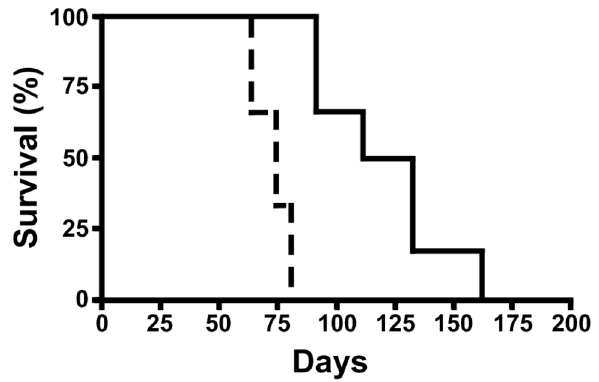
Figure 5. length of survival in the 2F7 NOD-SCID mouse model of AIDS-BL. In one group of mice (n = 6), 2F7 cells were pre- incubated with neutralizing antibody to CXCR5 prior to injection into mice. In the control group (n = 6), cells were pre-incubated with an isotype control antibody. The figure depicts a survival curve for the experiment. The number of days elapsing since the injection of 2F7 cells is shown on the x-axis, and the percentage of surviving mice is shown on the y-axis. The solid line depicts results for the anti-CXCR5 test group; the dotted line depicts results for the isotype control group. These results are significant (p < 0.0007, log-rank test). Two additional replicates of this experiment have been performed, with similar